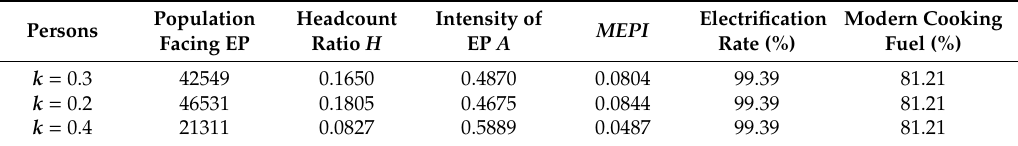
Table 6. People facing energy poverty with di ff erent deprivation